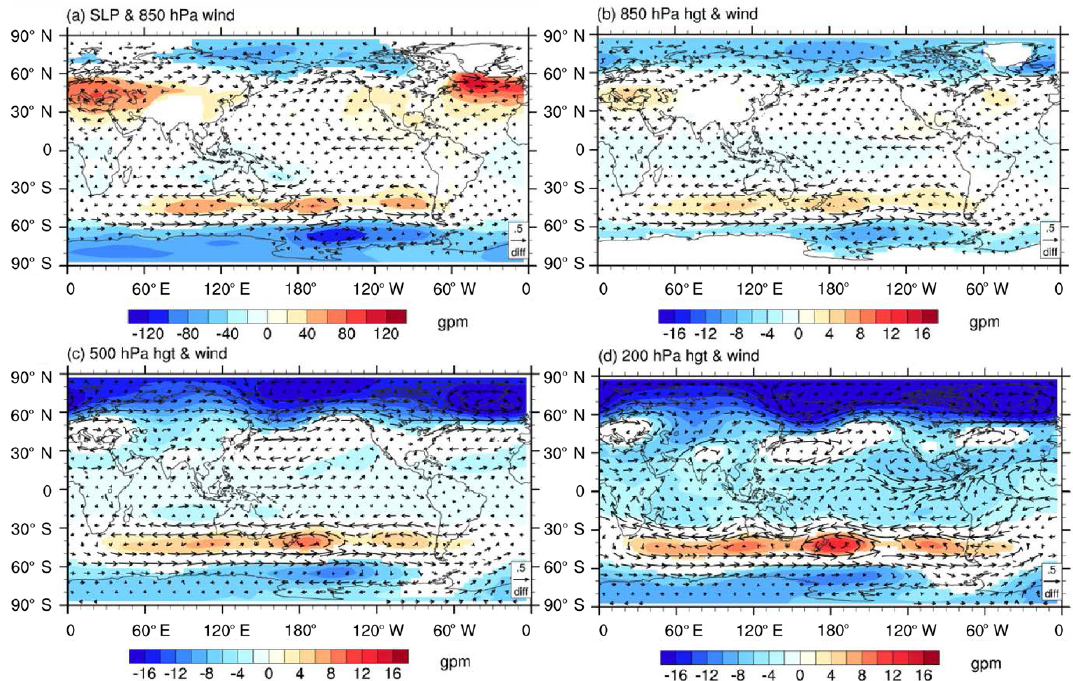
Figure 5. Differences in annual mean (a) sea level pressure and 850hPa wind, (b) geopotential height and wind at 850hPa, (c) geopotential height and wind at 500hPa, and (d) geopotential height and wind at 200hPa between cold and warm periods derived from the TraCE-ALL run. Those regions which were significant above the 95% confidence level are plotted.